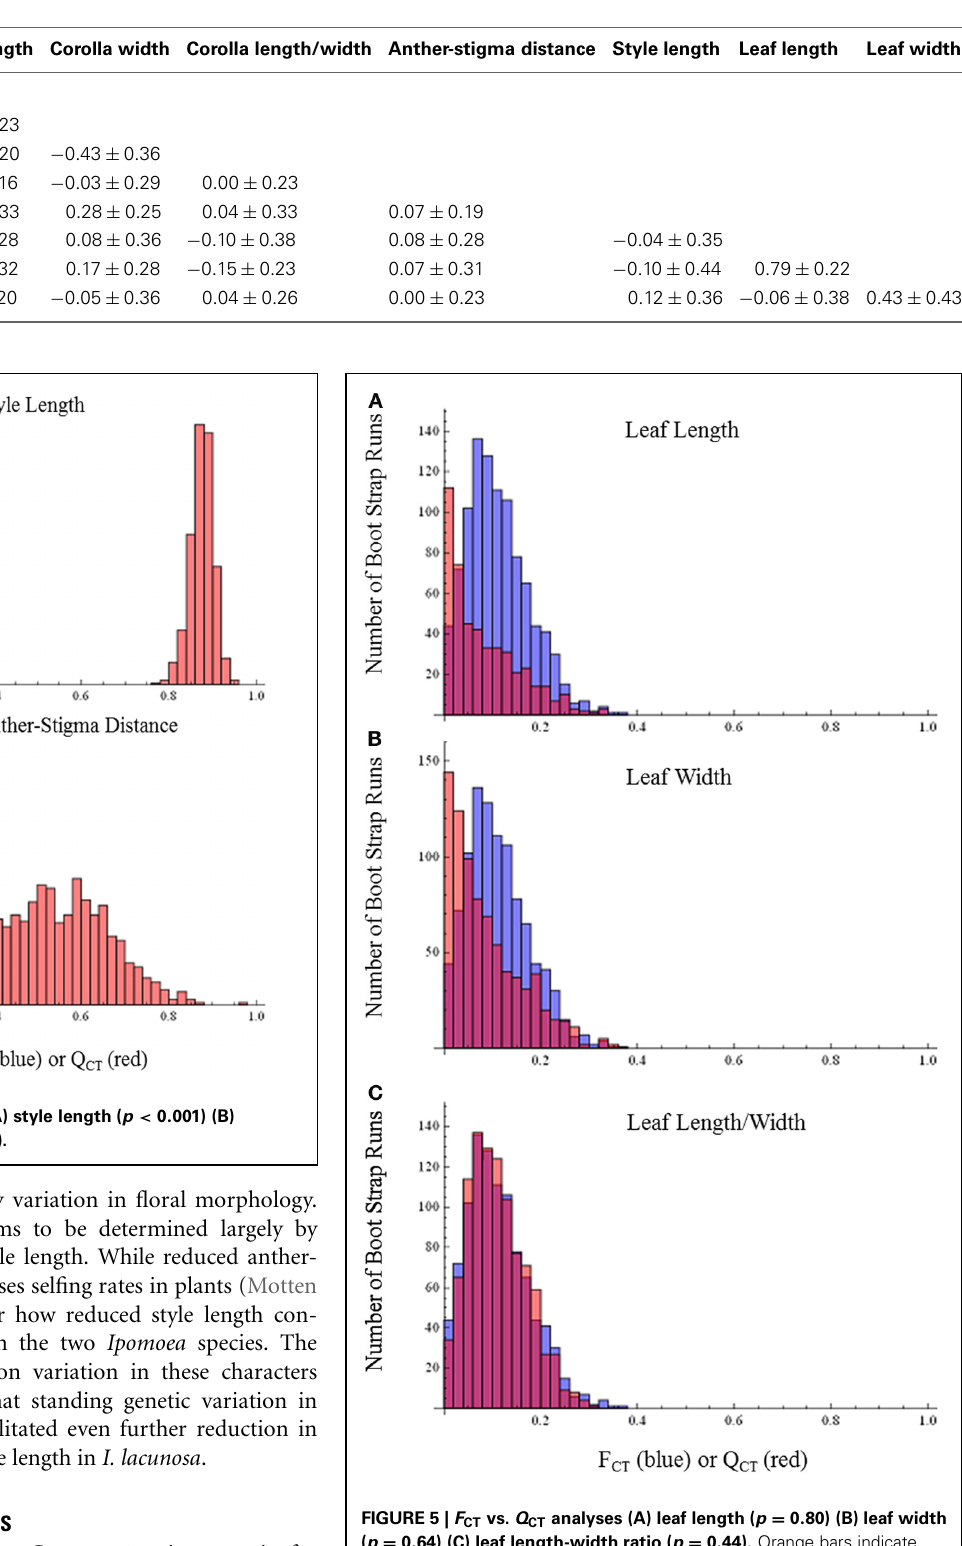
Table 3 | The average phenotypic correlations ± standard error between pairs of measured traits within populations of I. cordatotriloba and I. lacunosa .